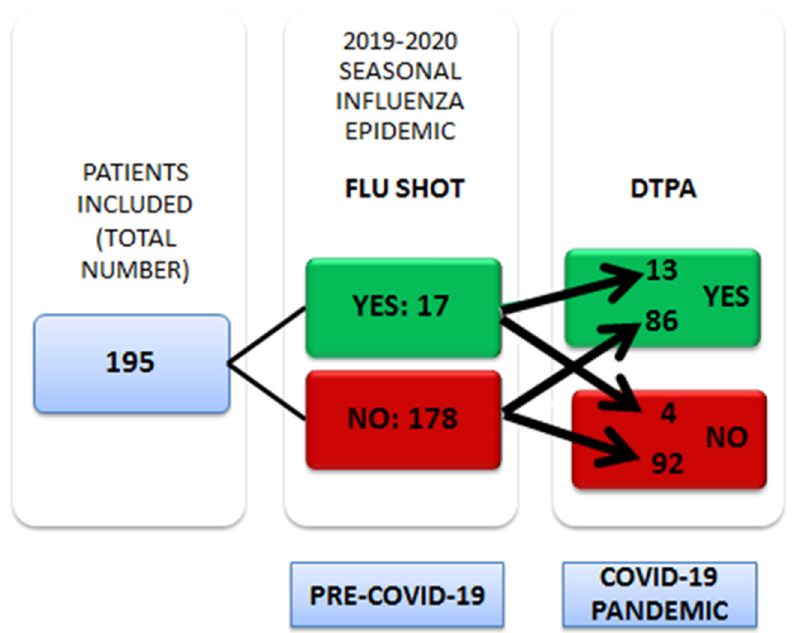
Figure 1. Trend of the uptake of immunization in pregnancy before and during the COVID-19 pandemic in our sample.